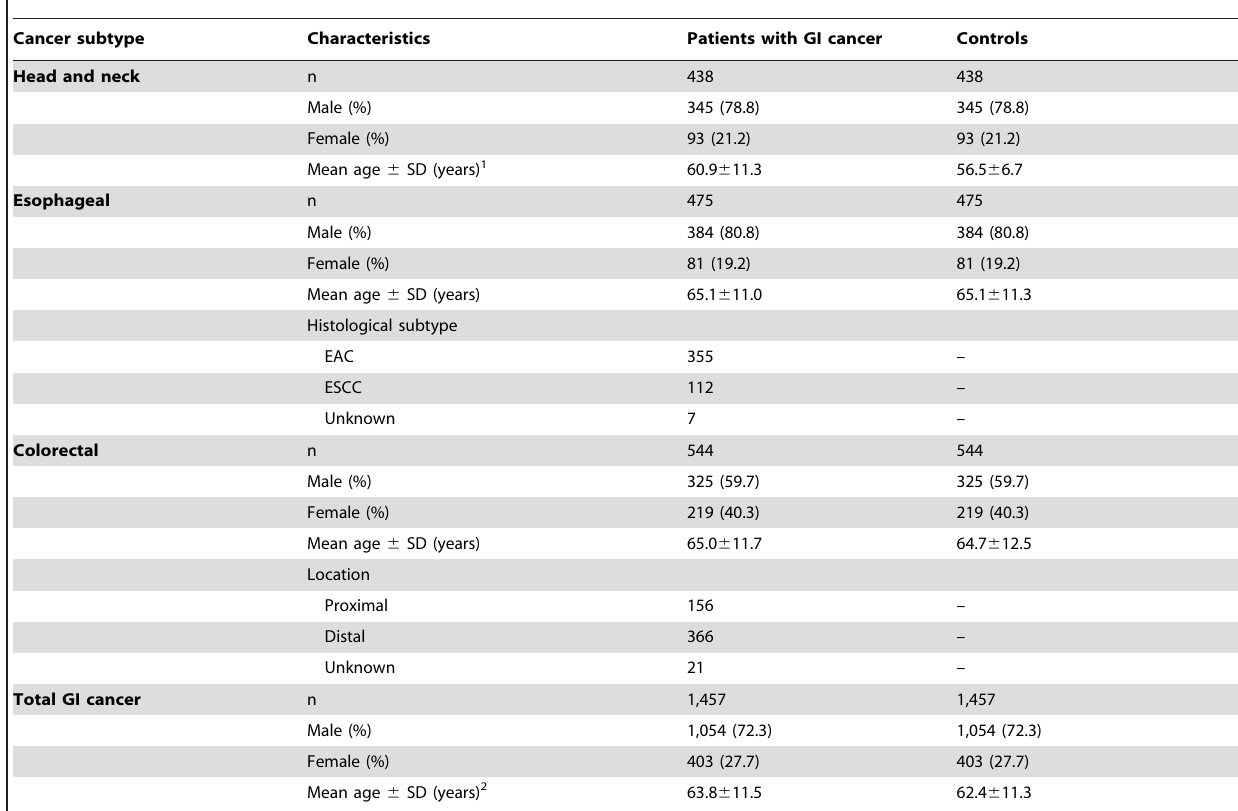
Table 2. Characteristics of the study population.